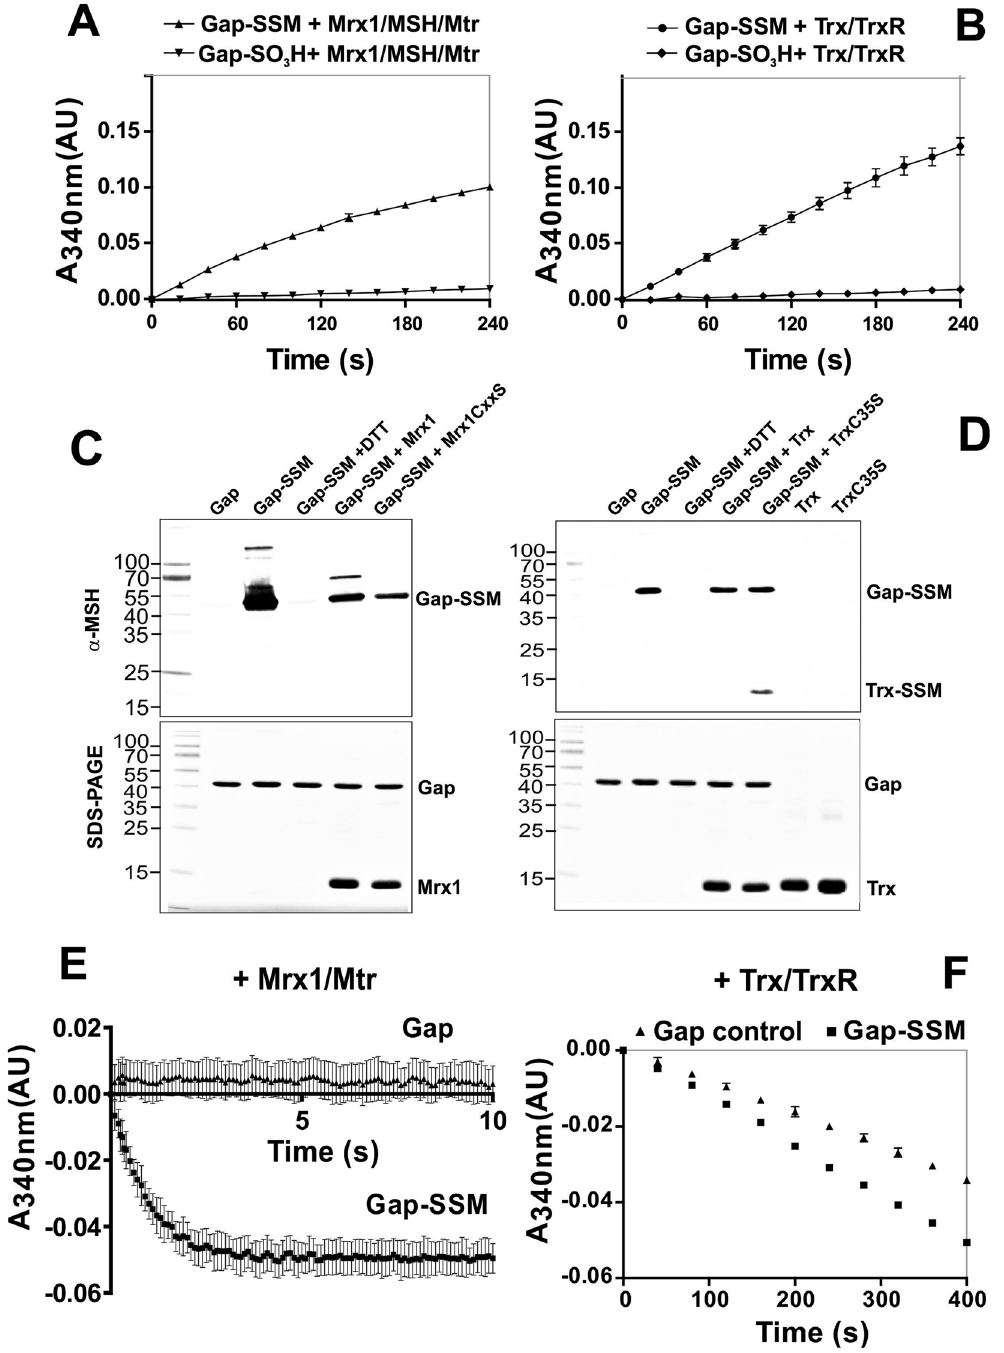
Figure 6. Re-activation of S -mycothiolated GapDH by the Trx/TrxR and Mrx/MSH/Mtr electron transfer pathways. (A , B) GapDH activity could be restored after demycothiolation of S -mycothiolated GapDH with Mrx1 and Trx as shown by NADH production in the G3P oxidation assay. In contrast, overoxidized GapDH that was treated with 10 mM H 2 O 2 alone could not be reactivated by the Mrx1 and Trx pathways. (C , D) MSH-specific non-reducing Western blot analysis confirmed the S -mycothiolation of GapDH in vitro and its demycothiolation by the Mrx1 and Trx pathways. The transfer of MSH to the Trx resolving Cys mutant TrxC35S is shown. (E , F) The Mrx1/MSH/Mtr and Trx/TrxR electron transfer pathways both reduce S - mycothiolated GapDH with different reaction rates as revealed by progress curves of NADPH consumption. The demycothiolation of GapDH by the Mrx1-pathway was faster compared to the Trx-pathway. All data represent mean values of three independent replicate experiments and the error bars given were calculated as standard error of the mean